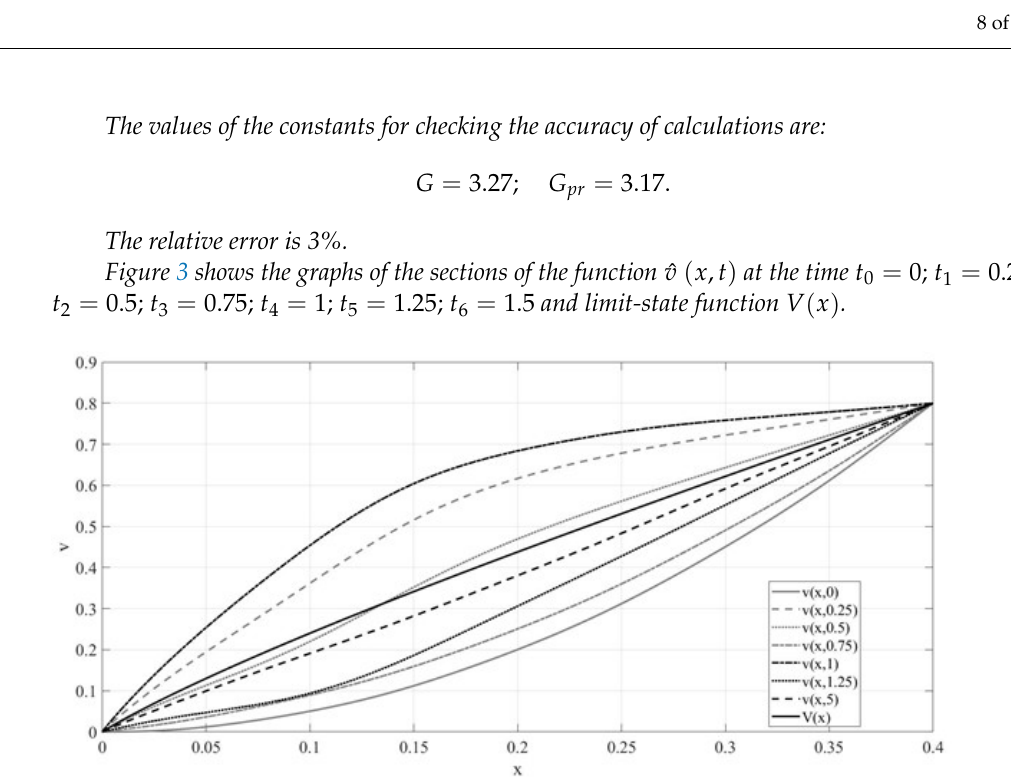
Figure 3. The graphs of the sections of the function ˆ v ( x , t ) at the time t 0 = 0; t 1 = 0.25; t 2 = 0.5; t 3 = 0.75; t 4 = 1; t 5 = 1.25; t 6 = 1.5 and limit-state function V ( x ) in the conditions of Example 1.